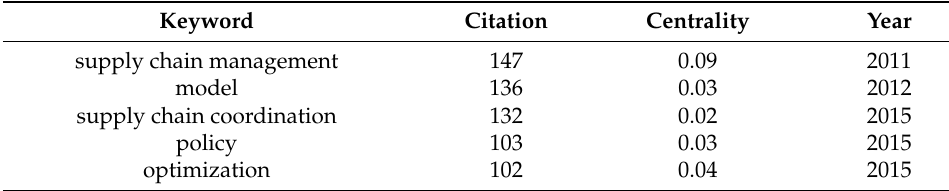
Table 4. Visualization of the keyword co-occurrence network.